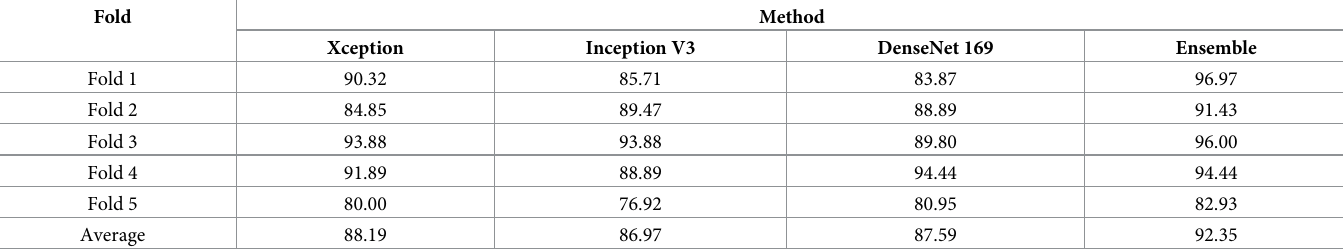
Table 5. Fold wise F1 scores concerning the base models and the ensemble method. All scores are reported in %. Fold